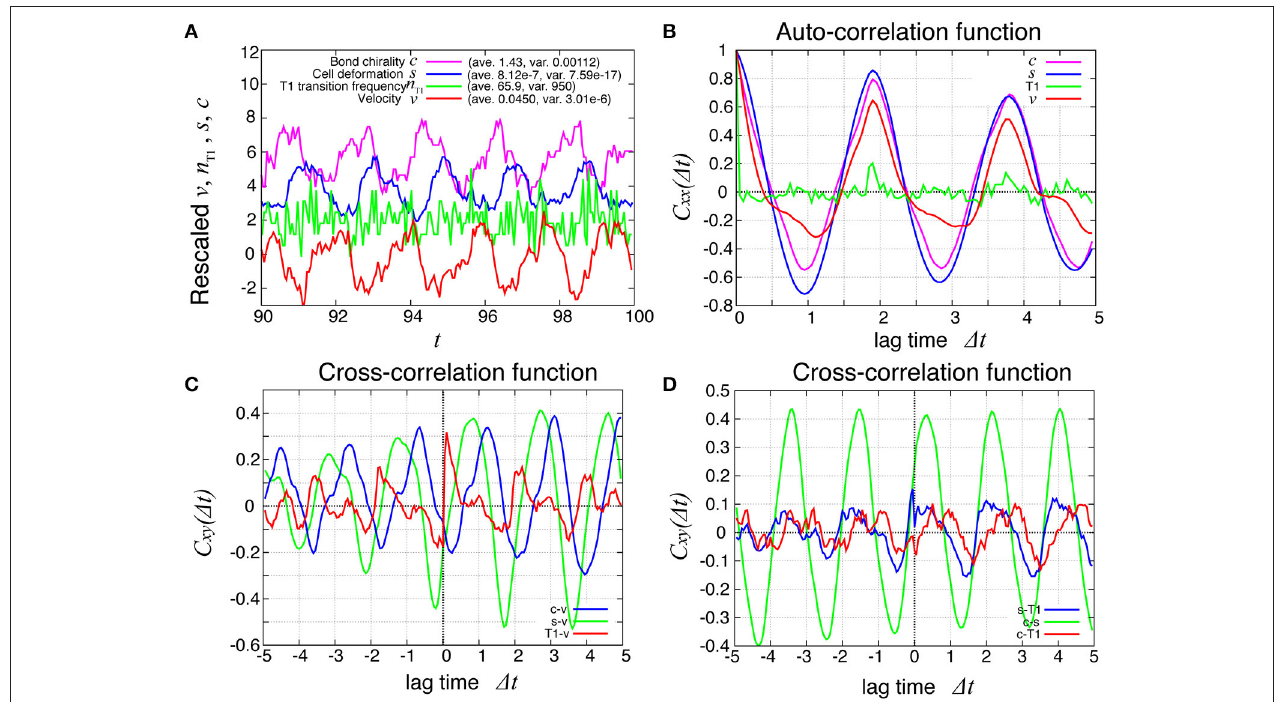
FIGURE 3 | Dynamics and correlation functions for K p 7.5 in the absence of line tension oscillation, showing oscillations of the rotation velocity, T1 transition = frequency, shape deformation and chirality in bond angles and correlations between them with time delays. (A) Time evolution of the global angular velocity v , (red), v , n T1 , s , or c , we plotted the number of T1 transitions per unit time, n T1 (green), elliptical anisotropy s (blue), and bond chirality c (purple). For these quantities of x = x x the scaled values as ( x ) /σ x with the average and standard deviation σ x . For visibility, the plots were offset by 2 ( n T1 ), 4 ( s ), and 6 ( c ). (B) Auto-correlations of − h i h i v , n T1 , s , and c . (C) Cross-correlation functions between v and the other quantities, given by C xv ( ∆ t ) δ x ( t ) δ v ( t ∆ t ) /σ x σ v , where x is n T1 , s , or c (red, green, and = h + i x x blue, respectively). Here, the positive time difference ∆ t means that x precedes v . δ x . (D) Cross-correlation functions given by = − h i C sn T1 ( ∆ t ) δ s ( t ) δ n T1 ( t ∆ t ) /σ s σ n T1 , C cs ( ∆ t ) δ c ( t ) δ s ( t ∆ t ) /σ c σ s , and C cn T1 ( ∆ t ) δ c ( t ) δ n T1 ( t ∆ t ) /σ c σ n T1 . = h + i = h + i = h + i